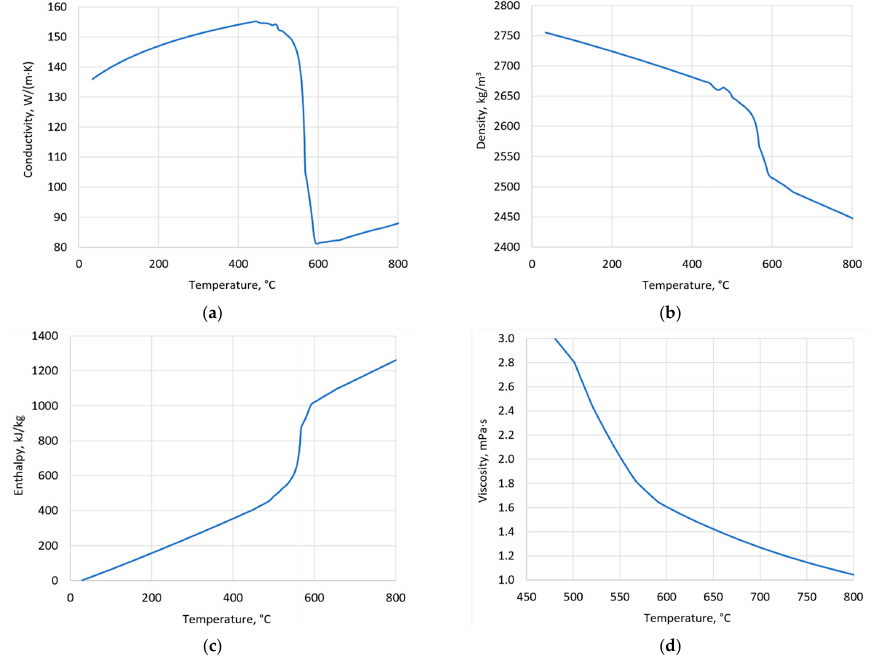
Figure 1. Temperature dependencies of thermophysical parameters of alloy (CompuTherm LLC Thermodynamic Databases): conductivity ( a ); density ( b ); enthalpy ( c ); viscosity ( d ).